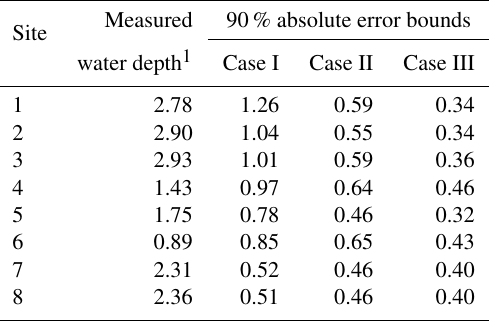
Table 4. The 90% confidence interval absolute error bounds (m) for three cases along with measured water depth (m) at eight sites for the January 2011